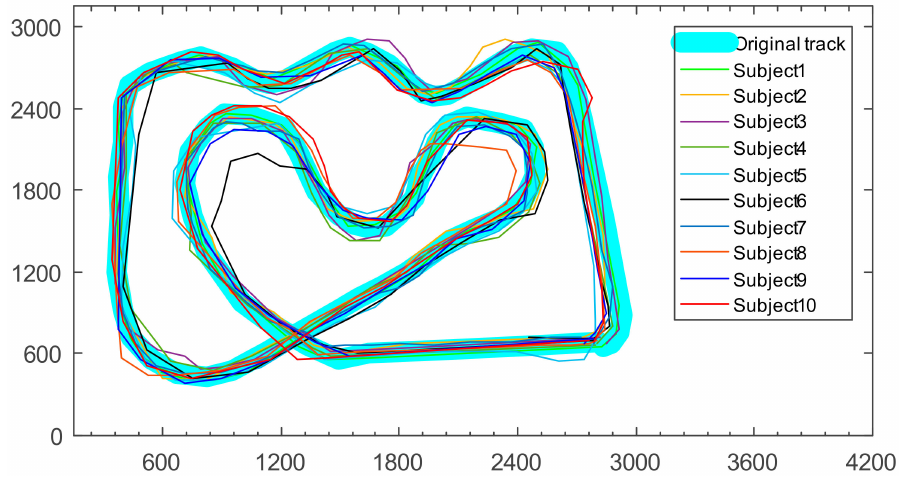
Figure 10. Track of autonomous